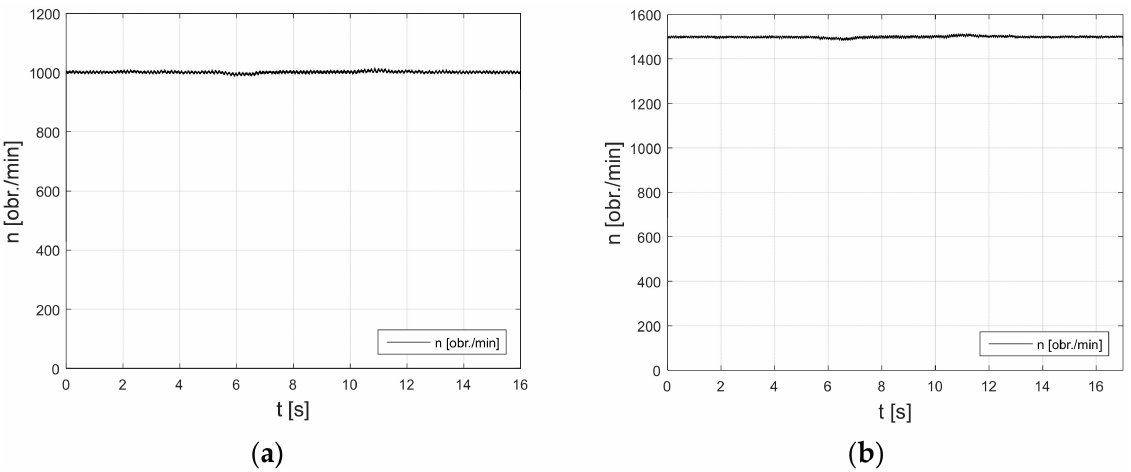
Figure 18. Waveforms of rotational speed (n) for the speed of: ( a ) 1000 rpm; ( b ) 1500